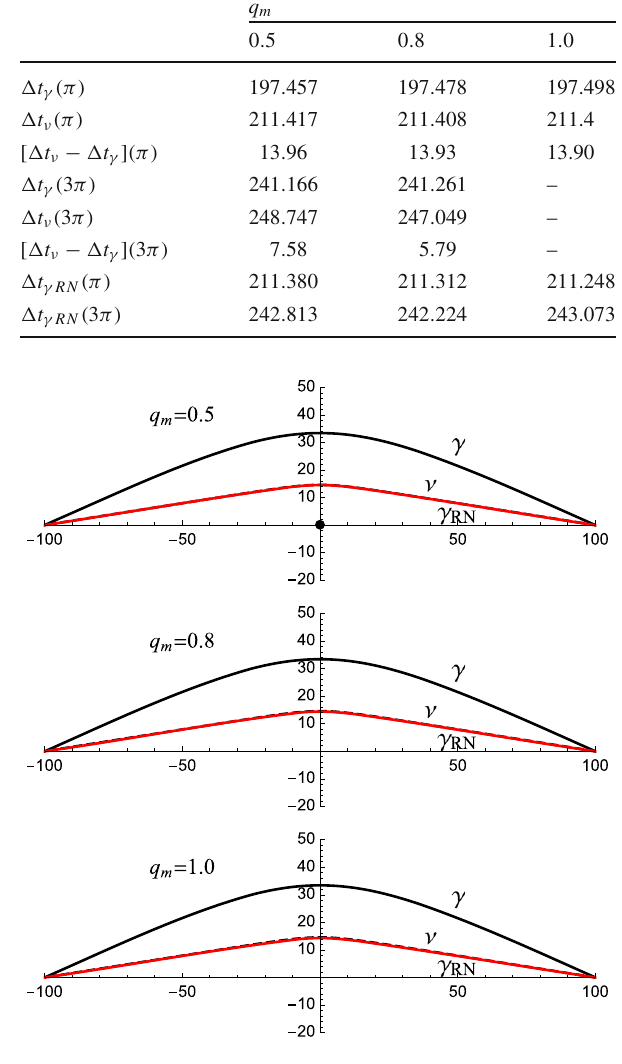
Fig. 7 Illustrative examples of geodesics of neutrinos ( ν , dashed) in Bardeen, photons ( γ , solid-black) in effective-Bardeen, and photons ( γ RN , solid-red) in RN geometries for three representative values of magnetic charge parameter q m = 0 . 5, 0 . 8, and 1 . 0. The impact param- eters for the geodesics are presented in Table